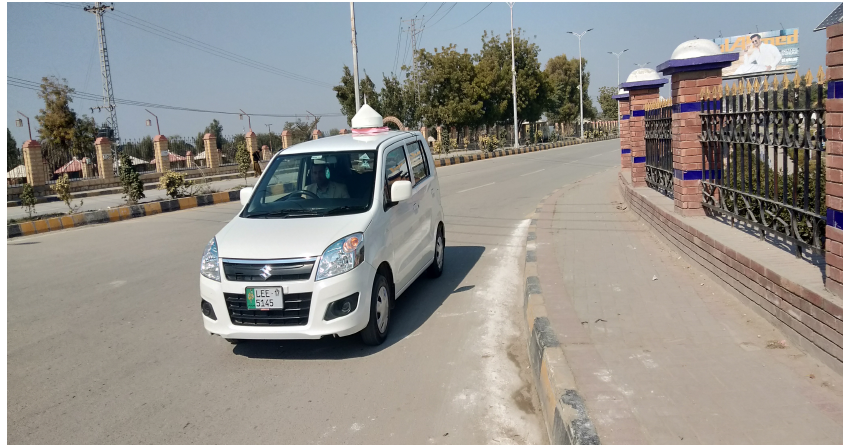
Figure 2. Instrumented test vehicle containing a roof-mounted antenna along with a PolaRx5s multi-frequency and multi-constellation GNSS receiver as used for field experimentation and data